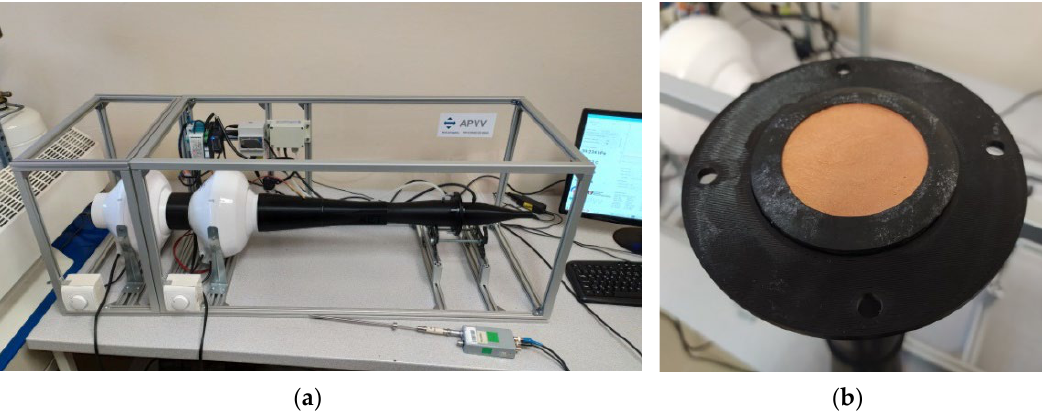
Figure 1. ( a ) Measuring stand for determining pressure losses, permeability, and resistance coefficient; ( b ) the location of the filter in the measuring stand.